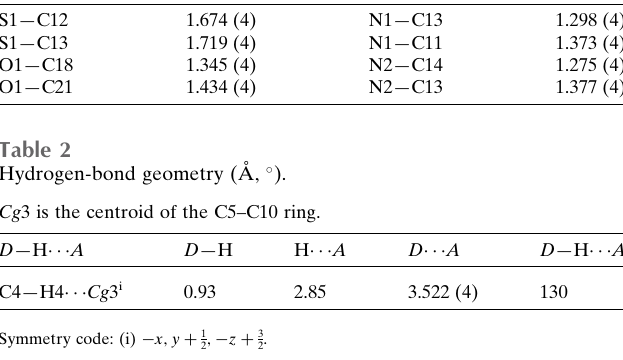
Table 1 Selected bond lengths (A˚ ).